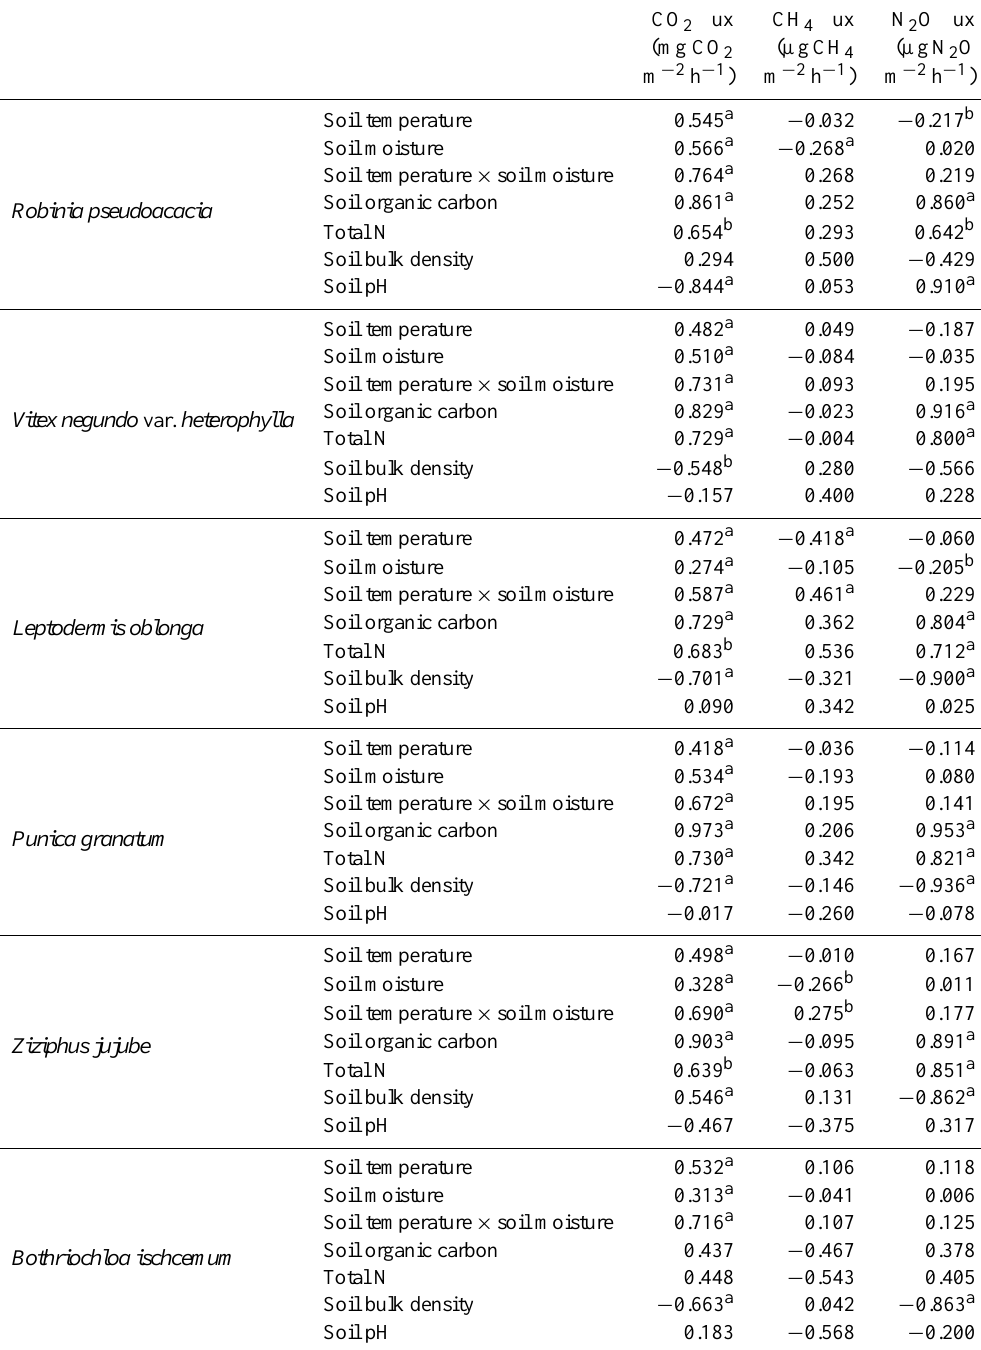
Table 5. Linear regressions for the relationship between soil properties and GHG